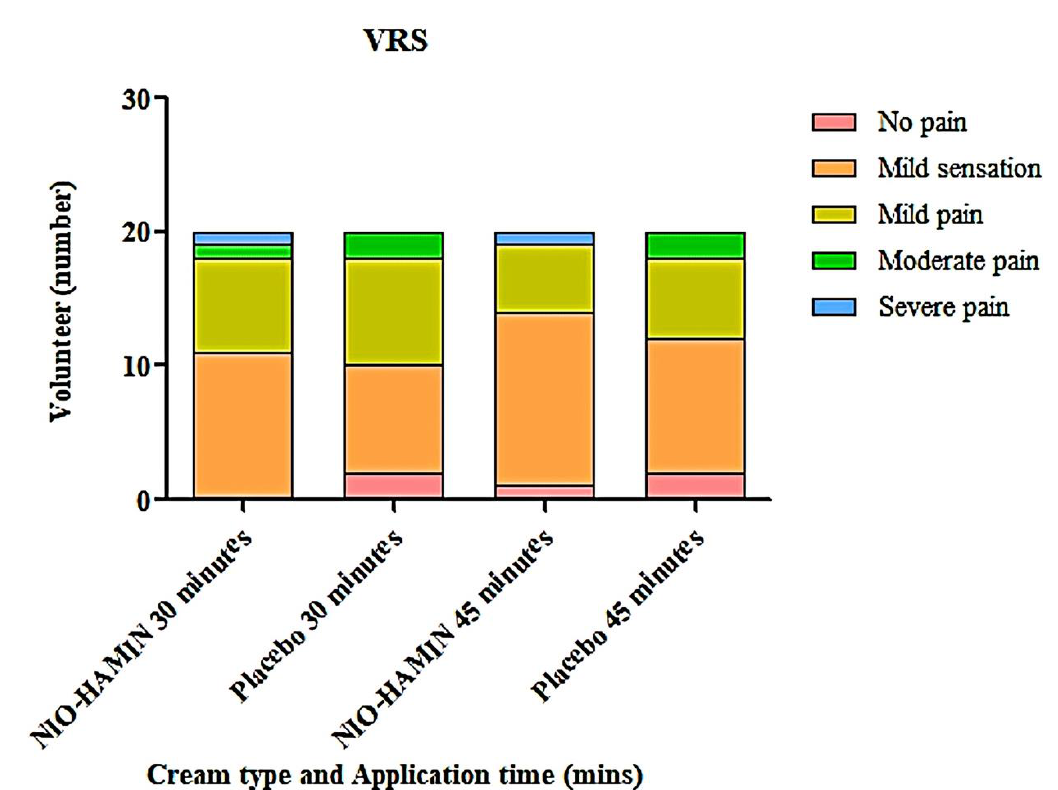
Figure 7. Verbal rating score (VRS) for NIO-HAMIN F1-C emulgel compared to placebo. Values are presented as number of subjects vs. treatment ( n = 20, p < 0.05).